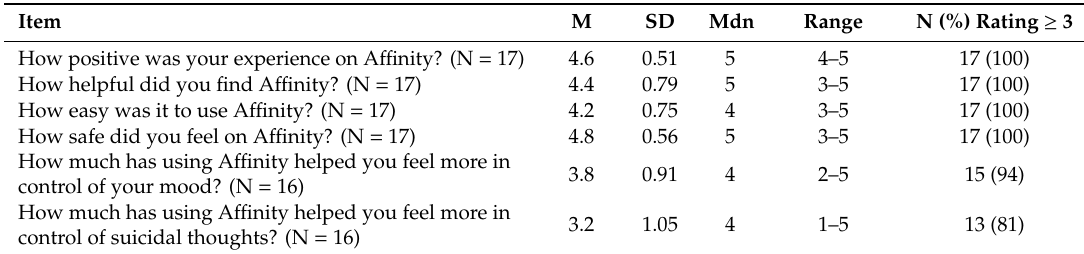
Table 4. Participant impressions of the A ffi nity intervention.